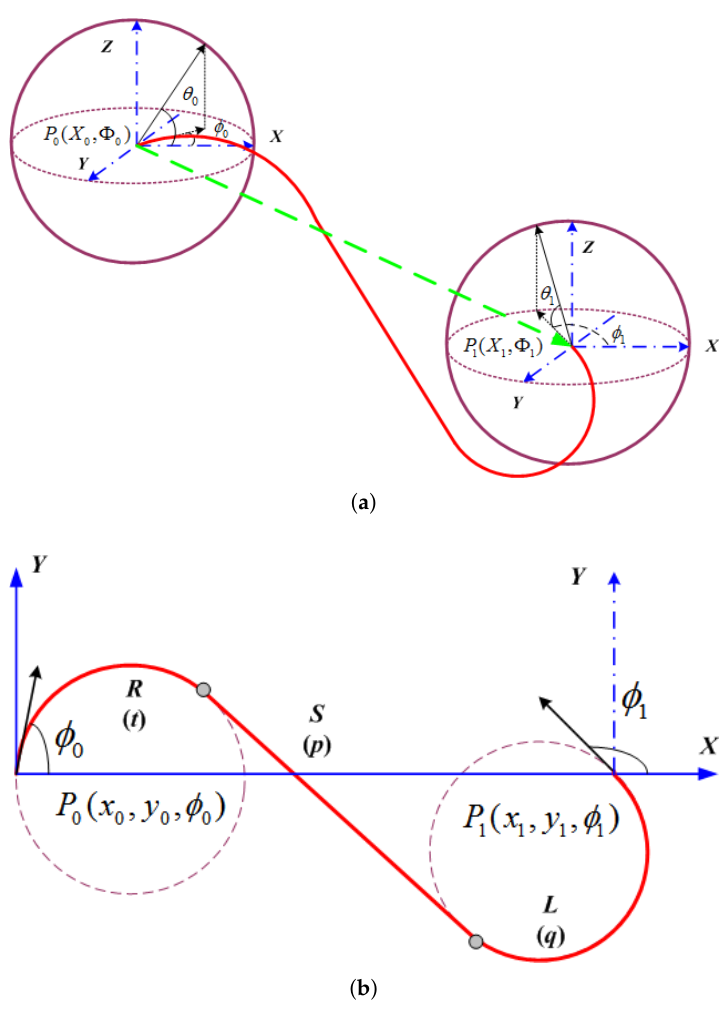
Figure 4. The RSL example of 2D and 3D Dubins curves. ( a ) 3D coordinates and its interpolated 3D Dubins curve; ( b ) 2D Dubins